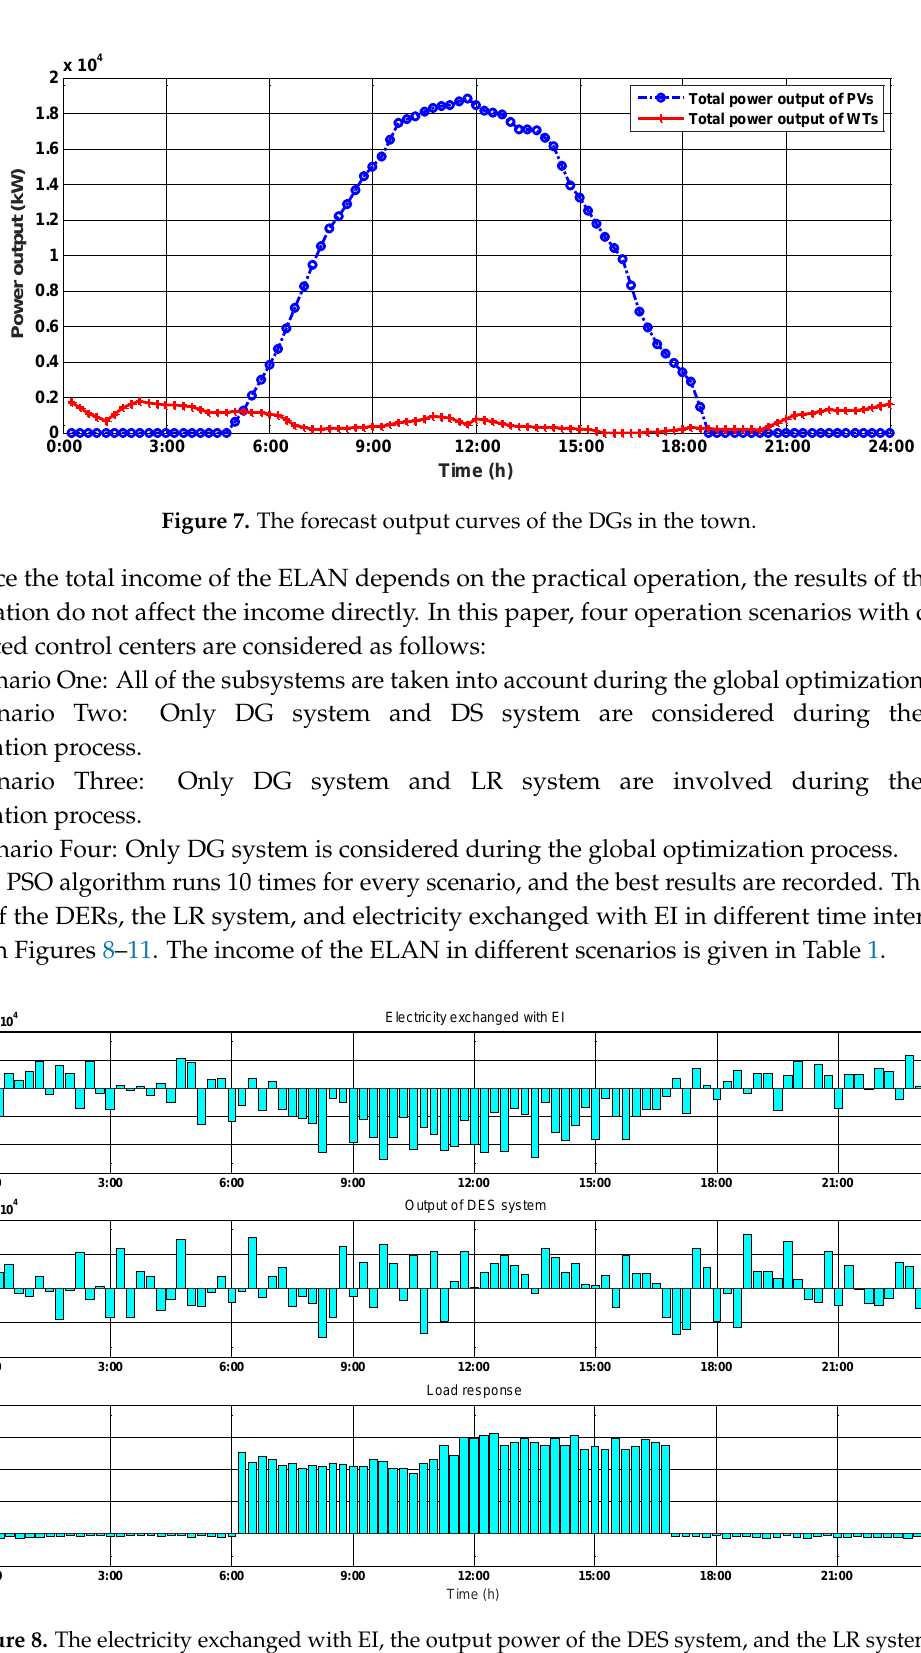
Figure 8. The electricity exchanged with EI, the output power of the DES system, and the LR system in Scenario One.